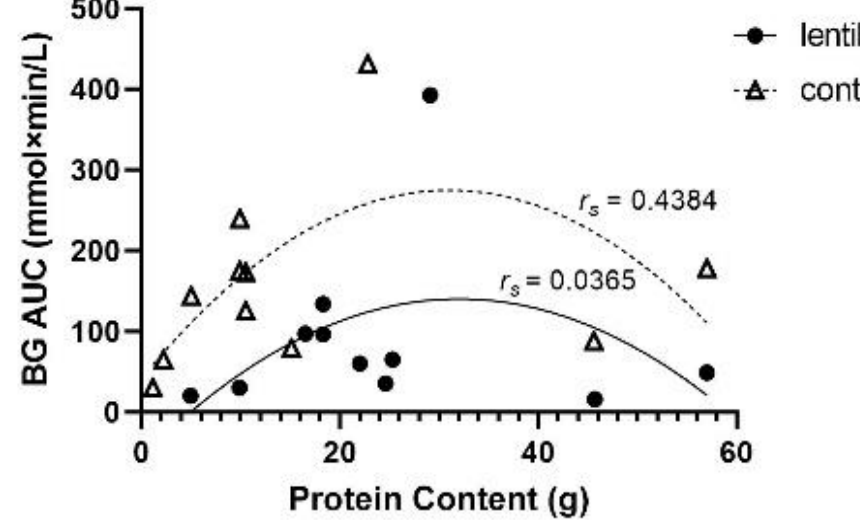
Figure 3. Relationship between area under the blood glucose response curve (BG AUC) and protein content (g) in lentil treatments and controls. Quadratic models for both lentil ( r s = 0.0365; n = 11; ns ) and control treatments ( r s = 0.4384; n = 11; ns ) best fit the data.